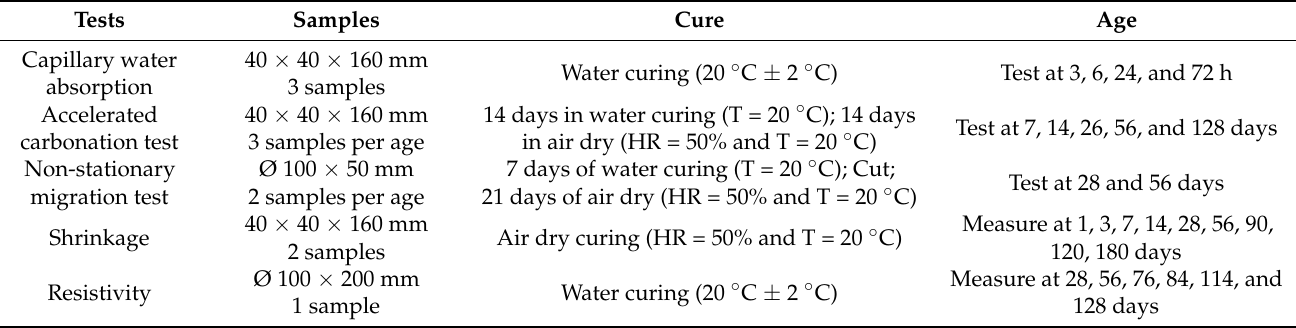
Table 4. Summary of the tests performed to study the durability of the restoration